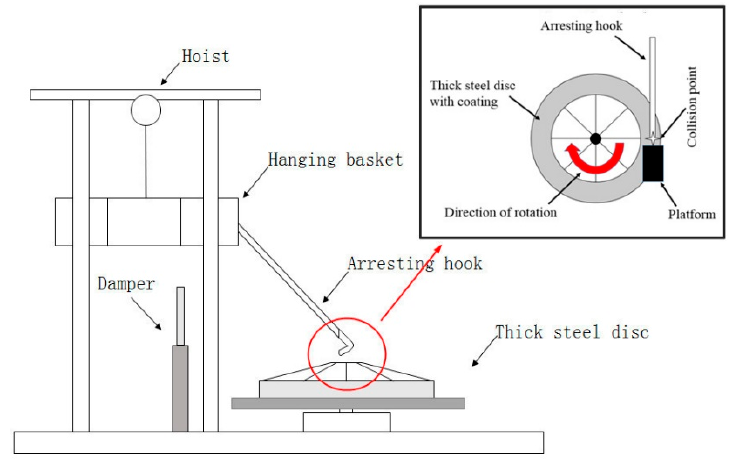
Figure 1. Schematic diagram of the test of arresting hook bounce.